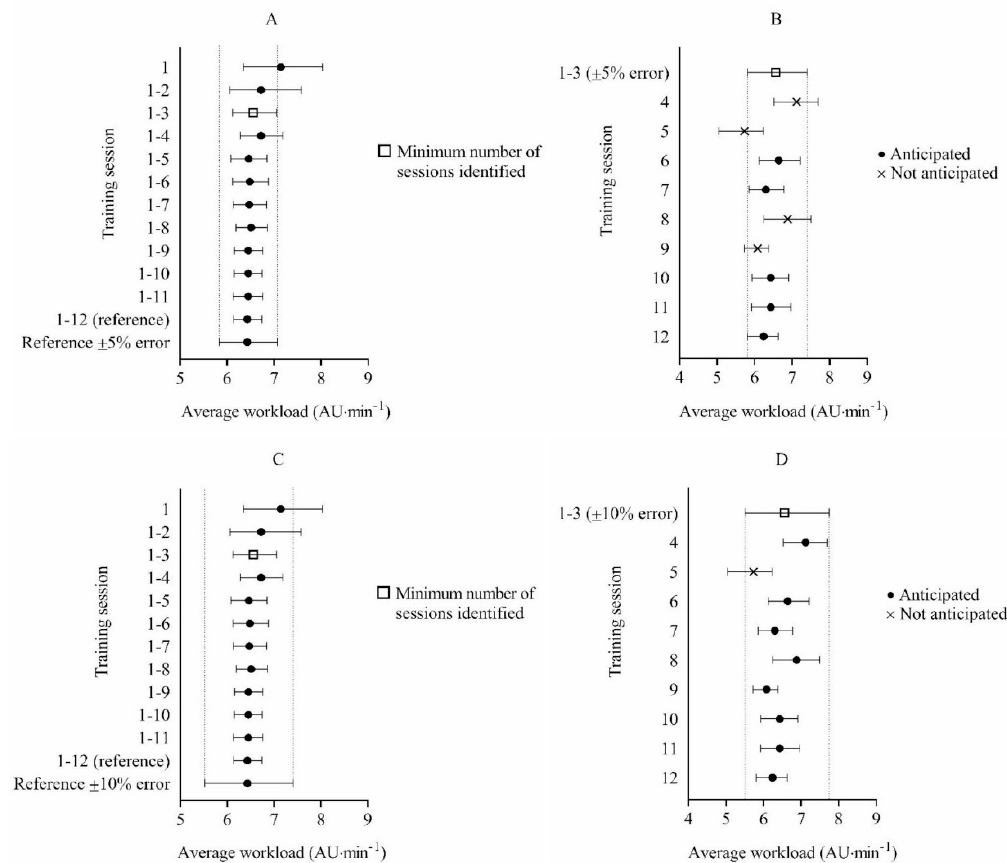
Figure 3. Bootstrap mean workload and bias-corrected 95% confidence intervals (CI) for determining the minimum number of sessions required to anticipate external workload with an acceptable error range of ± 5% ( A ) and ± 10% ( C ) during 5 vs. 5 vs. 5 games-based drills. Bootstrap mean workload and bias-corrected 95% CI for each future session and the accuracy of anticipating each session using the mean workload from sessions 1–3 with a ± 5% acceptable error range ( B ) and sessions 1–3 with a ± 10% acceptable error range ( D ) during 5 vs. 5 vs. 5 games-based drills.